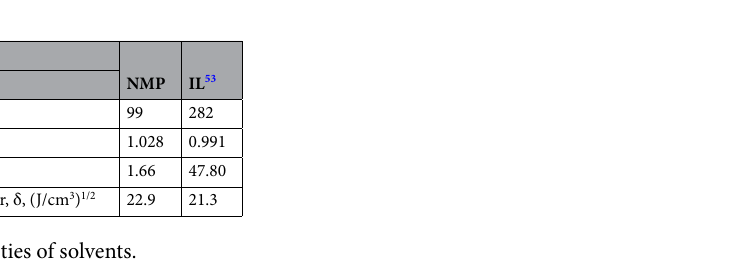
Table 2. Physical properties of solvents.